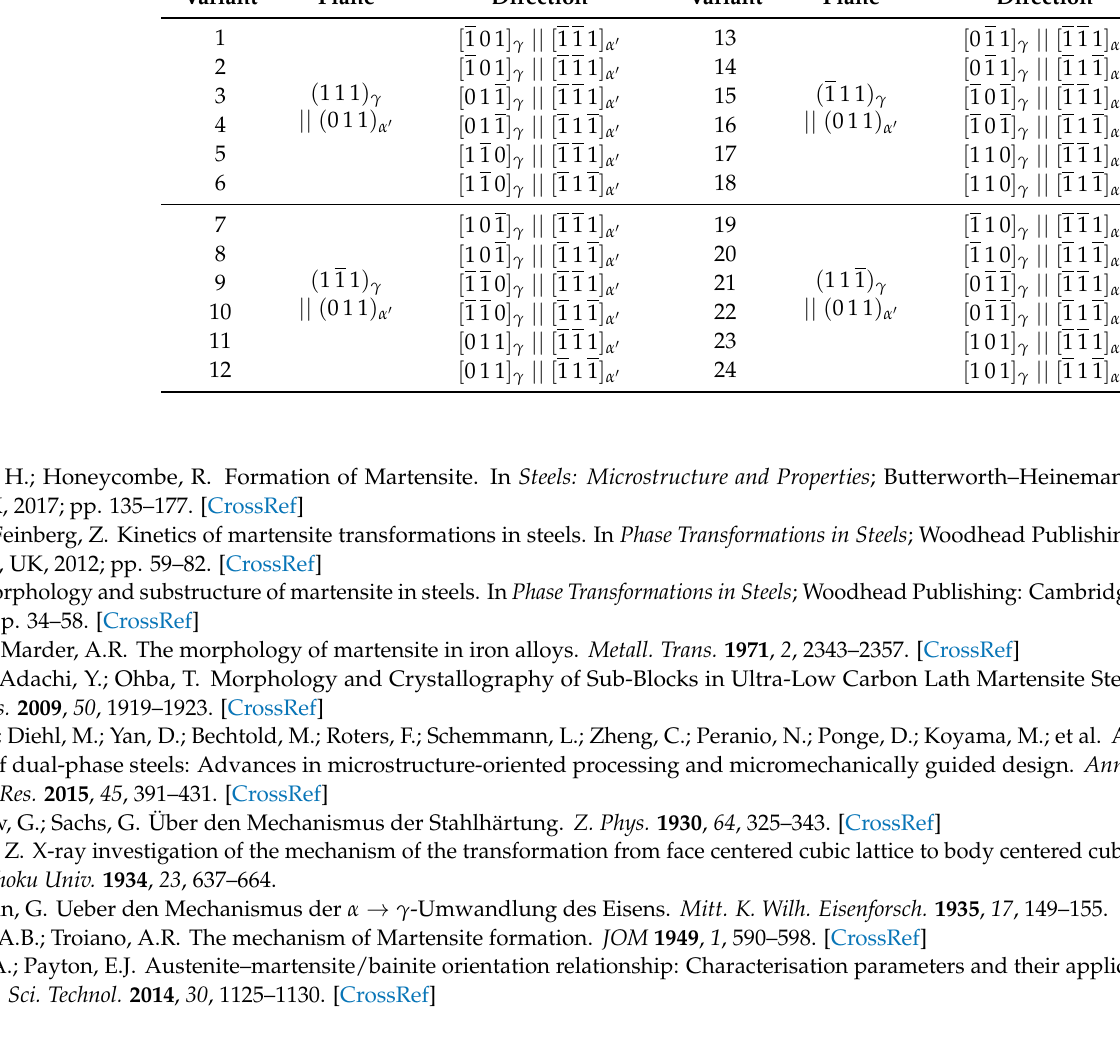
Table A1. Variants of the Kurdjumov–Sachs (KS) orientation relationship. Variant Plane Direction Variant